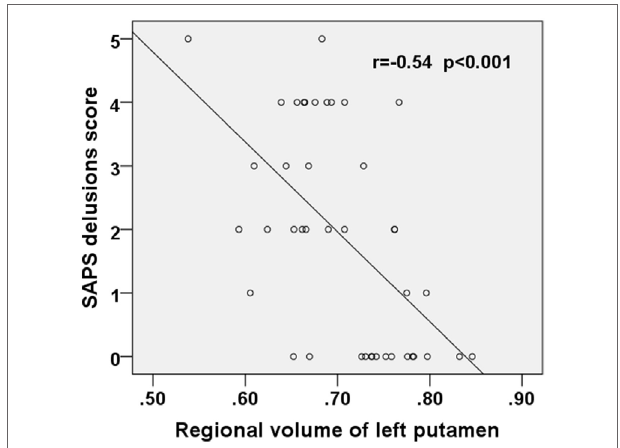
FigUre 3 | Scatter plot showing negative correlation between the SAPS delusions score and the regional volume of the left putamen in the first-episode schizophrenia patients. SAPS, Scale for the Assessment of Positive